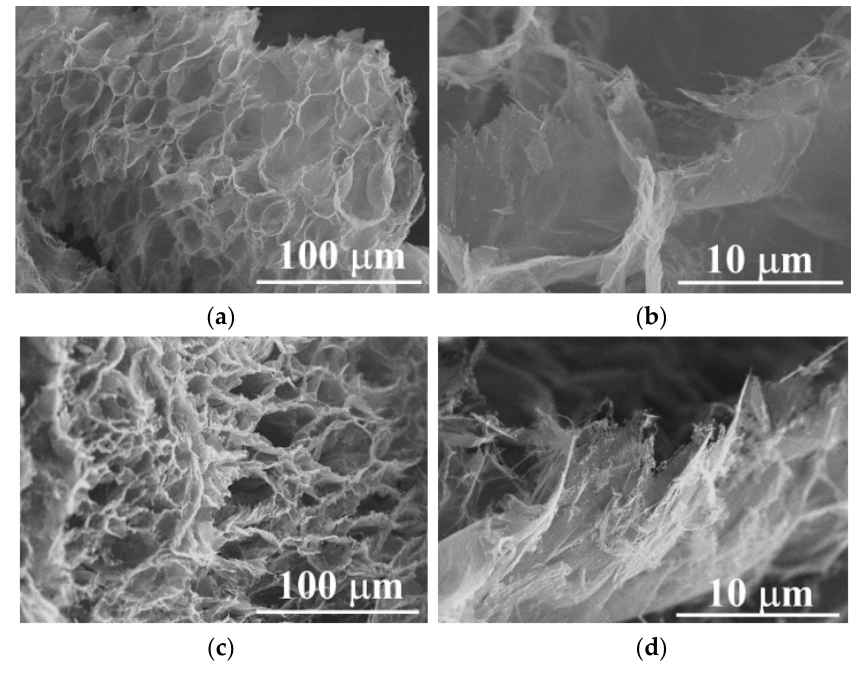
Figure 8. SEM micrographs of expanded samples ( a , b ) EG 0-2 and ( c , d ) EG 5-2 .